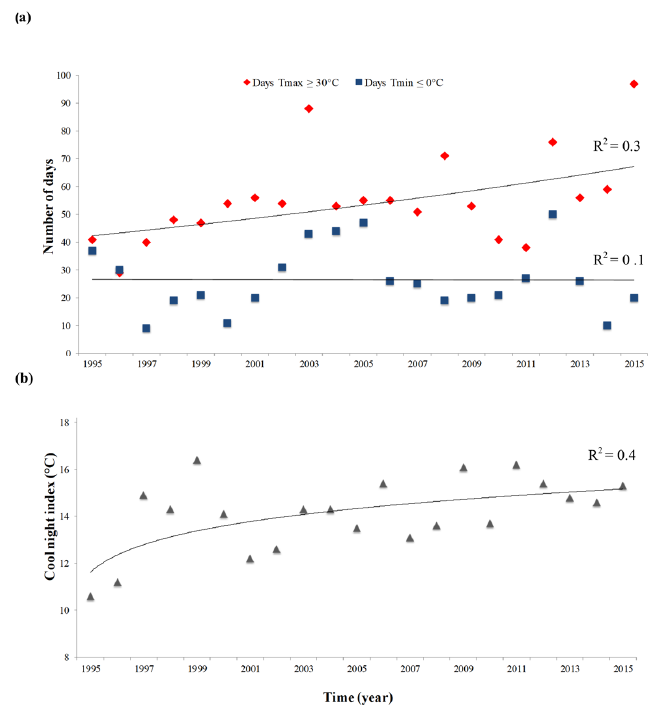
Figure 5. ( a ) Number of days with daily maximum air temperature (Tmax) equal or exceeded to 30 °C (black line and indicators) and with daily minimum temperature (Tmin) equal or below to 0 °C (grey line and indicators) in the white variety growing area (western sub ‐ area). ( b ) Cool night index (CI) trend in the white variety growing area (western sub ‐ area).